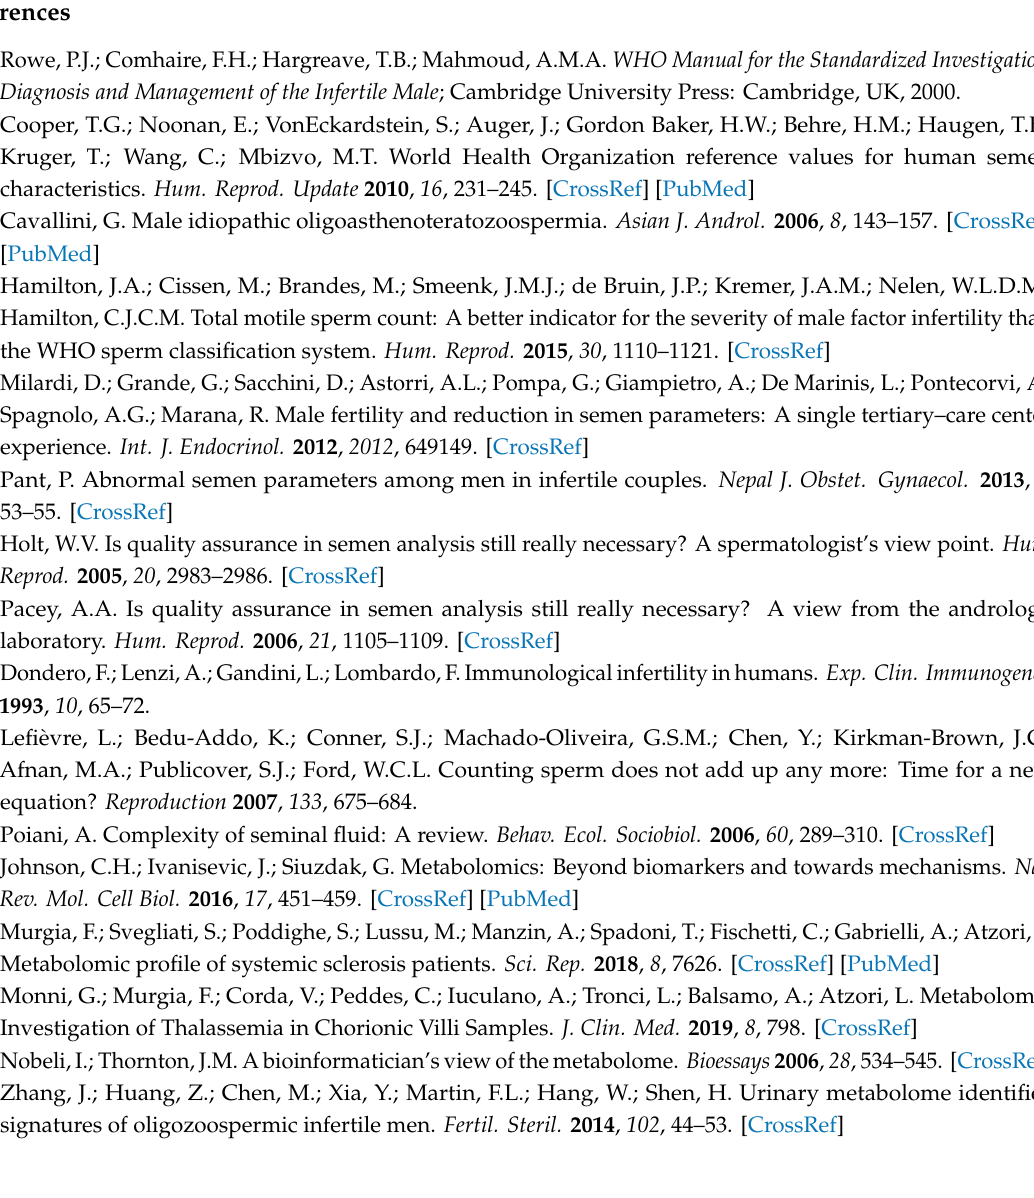
Figure S1: Comparison of a representative 500 MHz one-dimensional 1H NMR spectra recorded for seminal plasma samples from a healthy control and a oligozoospermic patient, Figure S2: PCA model of NMR samples of seminal fuid of control patients and patients a ff ected by oligozoospermia Figure S3: PLS correlation analysis between the metabolic profile of the patients and clinical